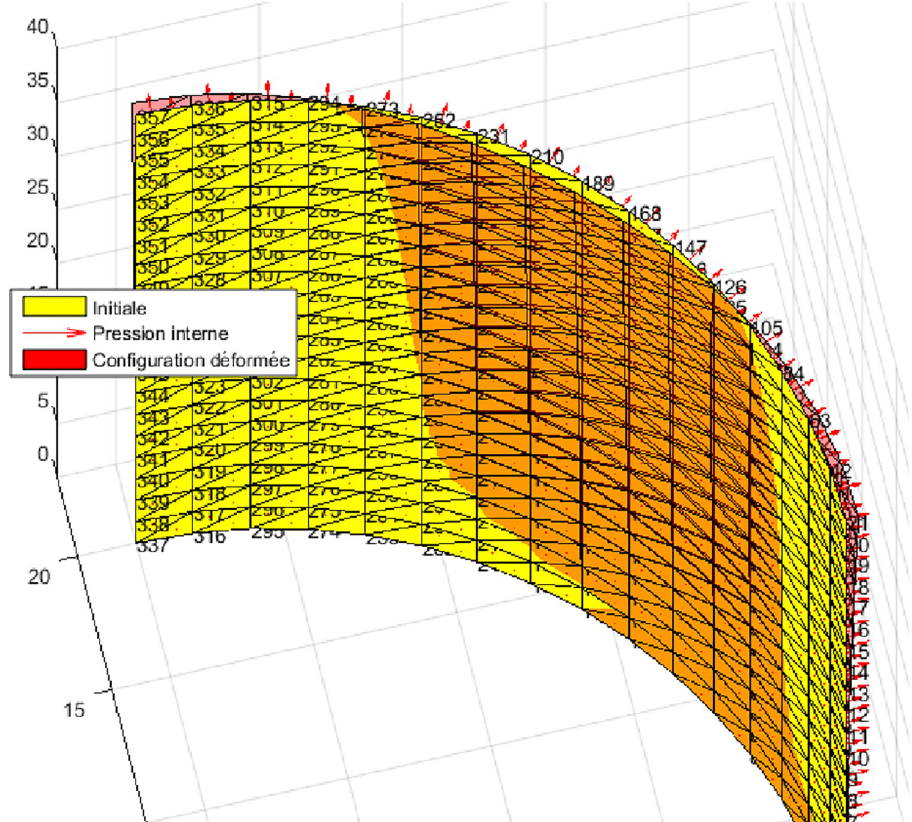
Fig 12. Isometric view of the deformed configuration of 1/8 of the cylinder for a 6 × 20